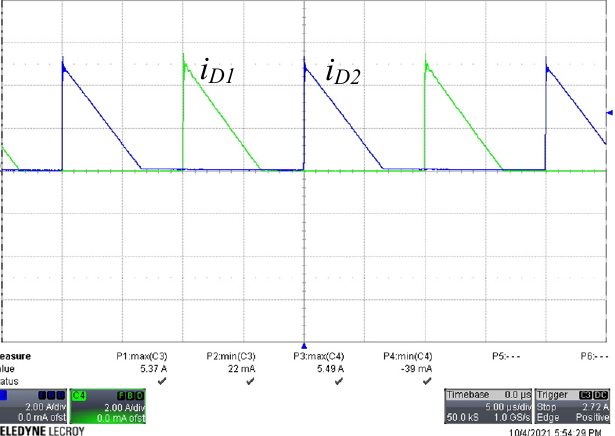
Figure 9. Current waveforms of the freewheel diodes. ( i D 1 , i D 2 : 2 A/div, time: 5 μ s/div).